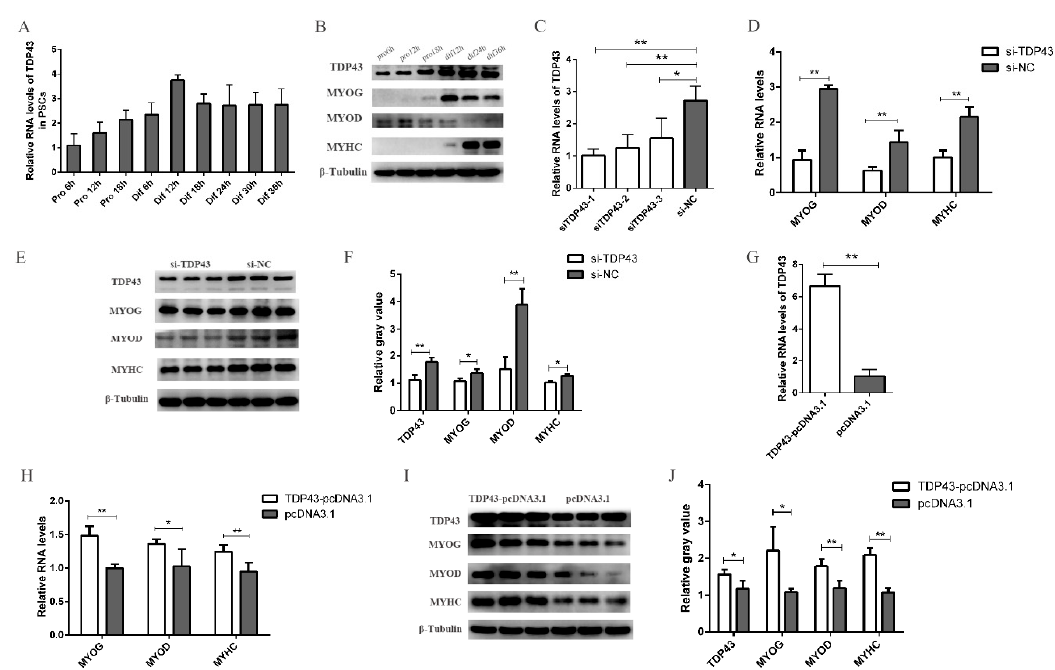
Figure 2. TDP43 promotes the porcine satellite cells (PSCs) differentiation. ( A ) Real-time PCR analysis of TDP43 expression in PSCs during the period of proliferation and differentiation. There was a 6h interval between each period. ( B ) Western blot analysis of TDP43, myogenin (MYOG), myogenic differentiation (MYOD), and myosin heavy chain (MYHC) protein expression levels in PSC in different periods. ( C ) The knockdown efficiency of TDP43 siRNA. ( D ) qPCR results showed that the mRNA expression of MYOG, MYOD, and MYHC were significantly decreased by TDP43 knockdown. ( E ) Western blot results showed that the protein expression of MYOG, MYOD, and MYHC were significantly decreased by TDP43 knockdown. ( F ) Quantitative analysis of Western blot results. ( G ) The overexpression efficiency of TDP43-pcDNA3.1. ( H ) qPCR results showed that TDP43-pcDNA3.1 significantly increased the mRNA expression of MYOG, MYOD, and MYHC. ( I ) Western blot results showed that TDP43-pcDNA3.1 significantly increased the protein expression of MYOG, MYOD, and MYHC. ( J ) Quantitative analysis of Western blot results. Mean values ± SD, n = 3. * means p < 0.05, ** means p < 0.01.